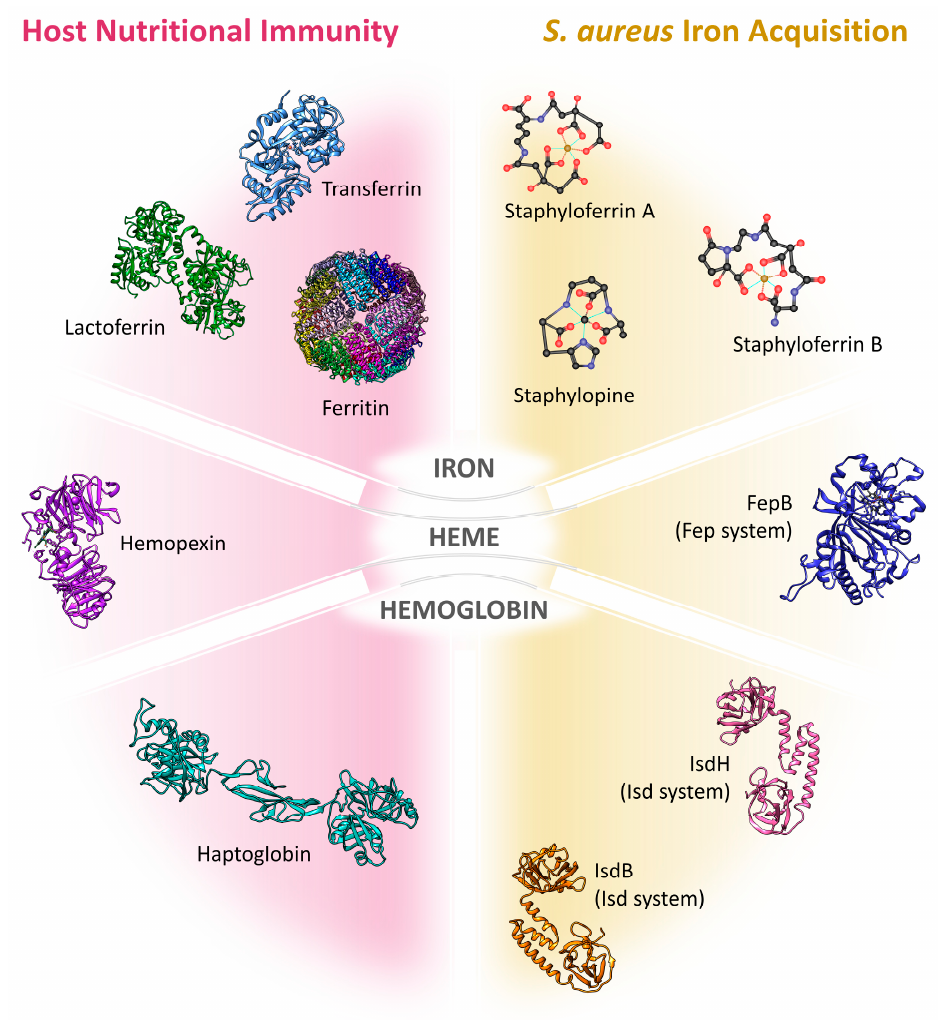
Figure 1. Schematic illustration of human proteins recruited in iron sequestration within the nutritional immunity (left), and Staphylococcus aureus e ff ectors in iron retrieval (right). For protein representation, the following Protein Data Bank entries have been used: transferrin (1d3k), lactoferrin (1b0l), ferritin (1fha), hemopexin (1qhu), Hp 1-1 (extracted from 4wjg), IsdB N1N2 (extracted from 5vmm), IsdH N2N3 (extracted from 6tb2), FepB (3o72, illustration of the homolog Escherichia coli EfeB), and Hb / heme / iron (1a3n). Staphyloferrin A and B, and staphylopine have been modelled on the basis of Endicott et al. [46] and Deane [47] works, respectively. Proteins are divided into three groups based on the source of iron they exploit.